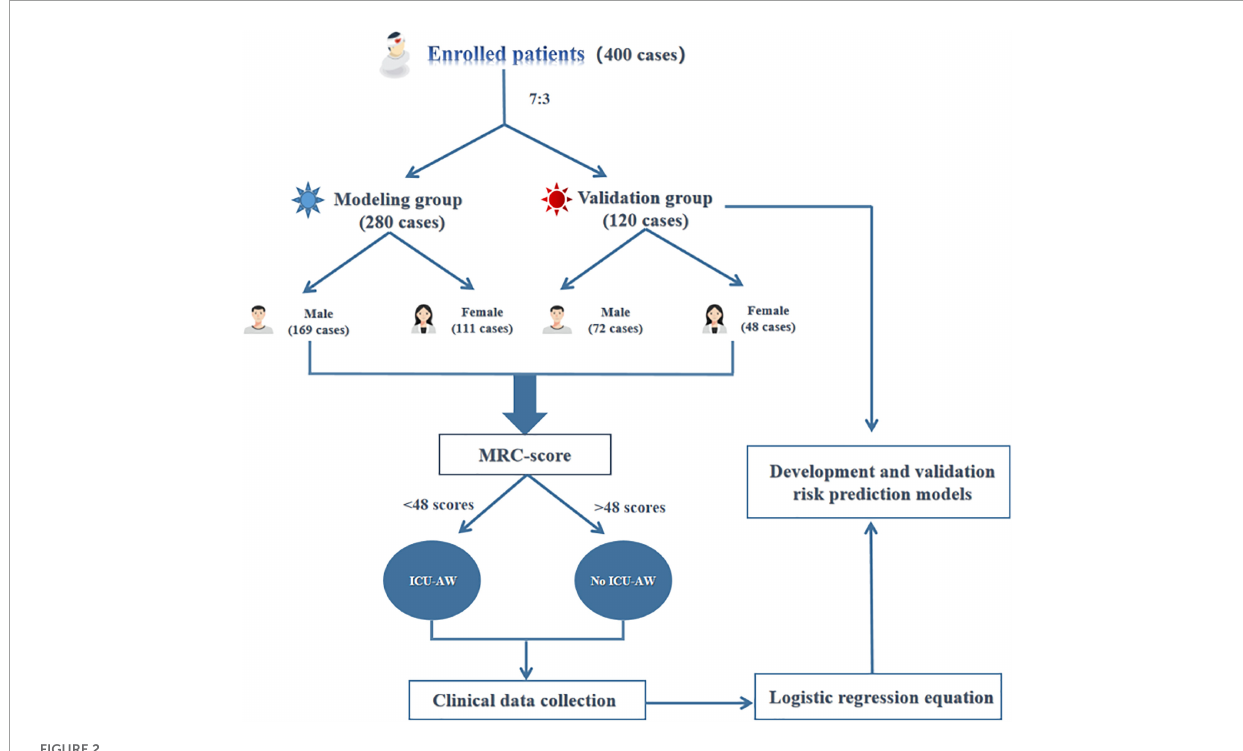
FIGURE2 Research flow